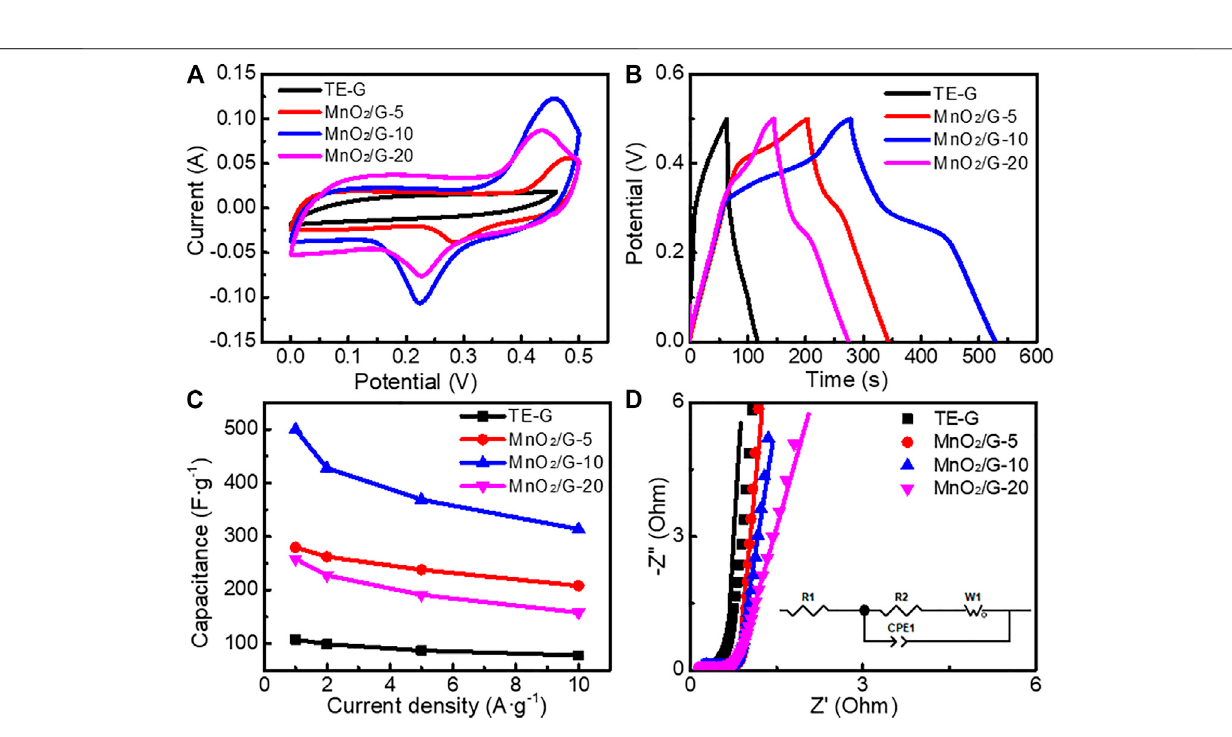
Frontiers in Chemistry |